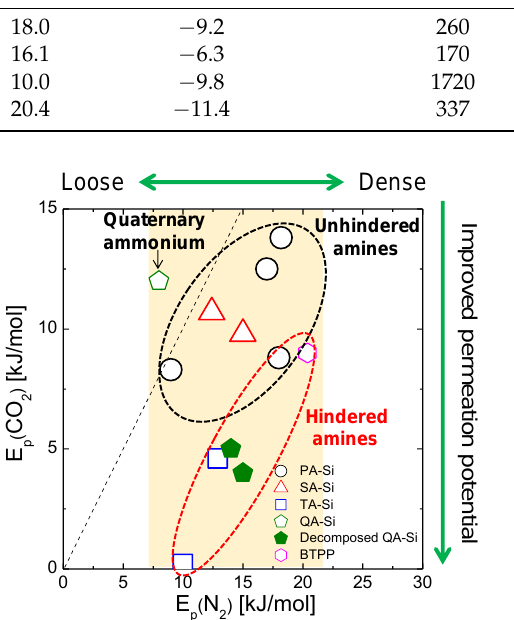
Figure 18. Relationships of E p ( N 2 ) vs. E p ( CO 2 ) for amine-functionalized organosilica membranes. Results were reorganized from refs. [21–23].